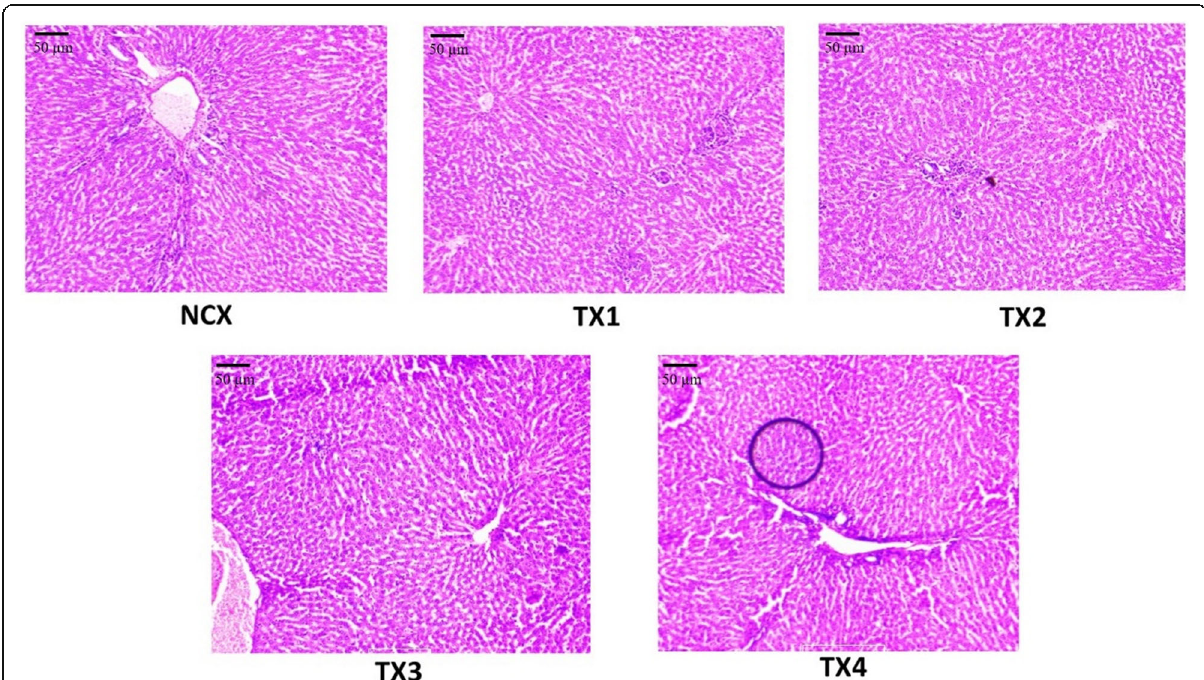
Fig. 3 The histopathology of Liver from the different group of swiss albino mice (40 × magnification; Scalar bar: 50 μ m). The tissue slices displayed intact hepatic parenchyma included of hepatocytes, central vein and portal triad. No significant mixed macro and micro vesicular steatosis, vacuolated hepatocytes or any kind of infiltration was observed in the liver tissue (hepatocytes). Hepatocytes were organized in cords with intact cellular and nucleus borders, when compared to normal control group (NCX). Where NCX: Normal control group; TX1: Sub-acute toxicity group 1 (250 mg/kg/day/p.o); TX2: Sub-acute toxicity group 2 (500 mg/kg/day/p.o); TX3: Sub-acute toxicity group 3 (1000 mg/kg/day/p.o); TX4: Sub-acute toxicity group 4 (2000